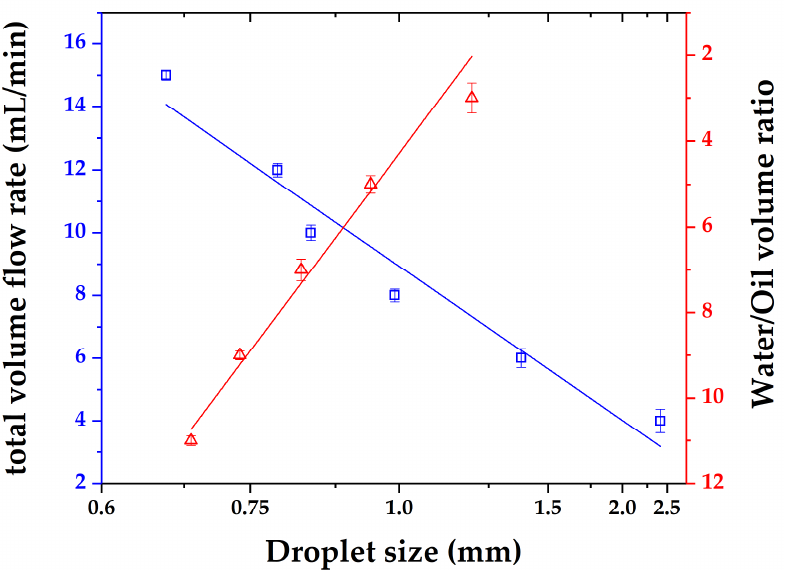
Figure 10. Relationship of droplet size to total flow rate ( blue ) and volume ratio of water to n-butanol ( red ).